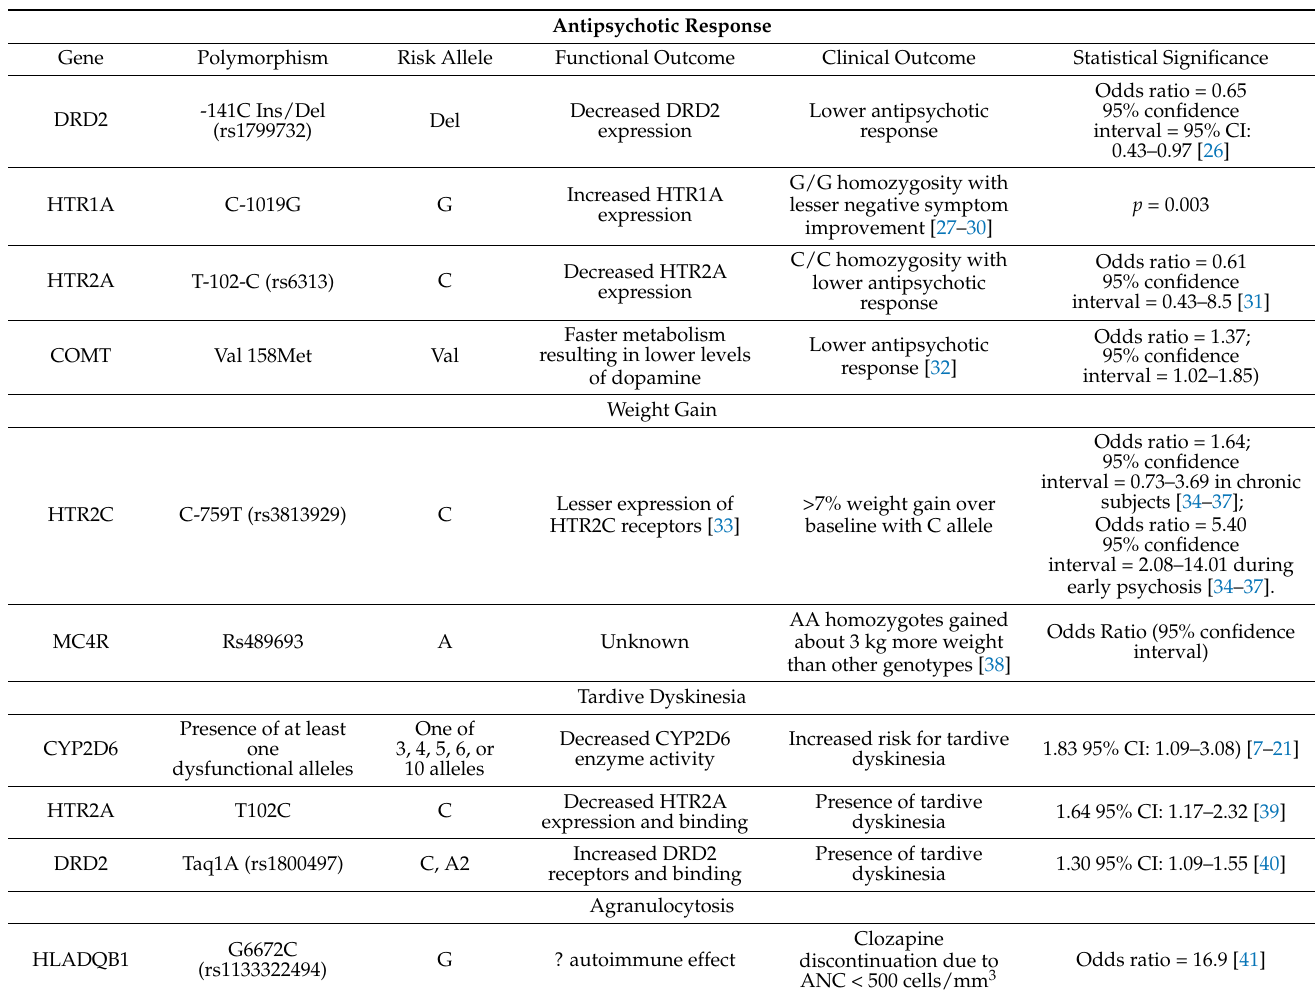
Table 1. Genetic biomarkers for antipsychotic response and adverse